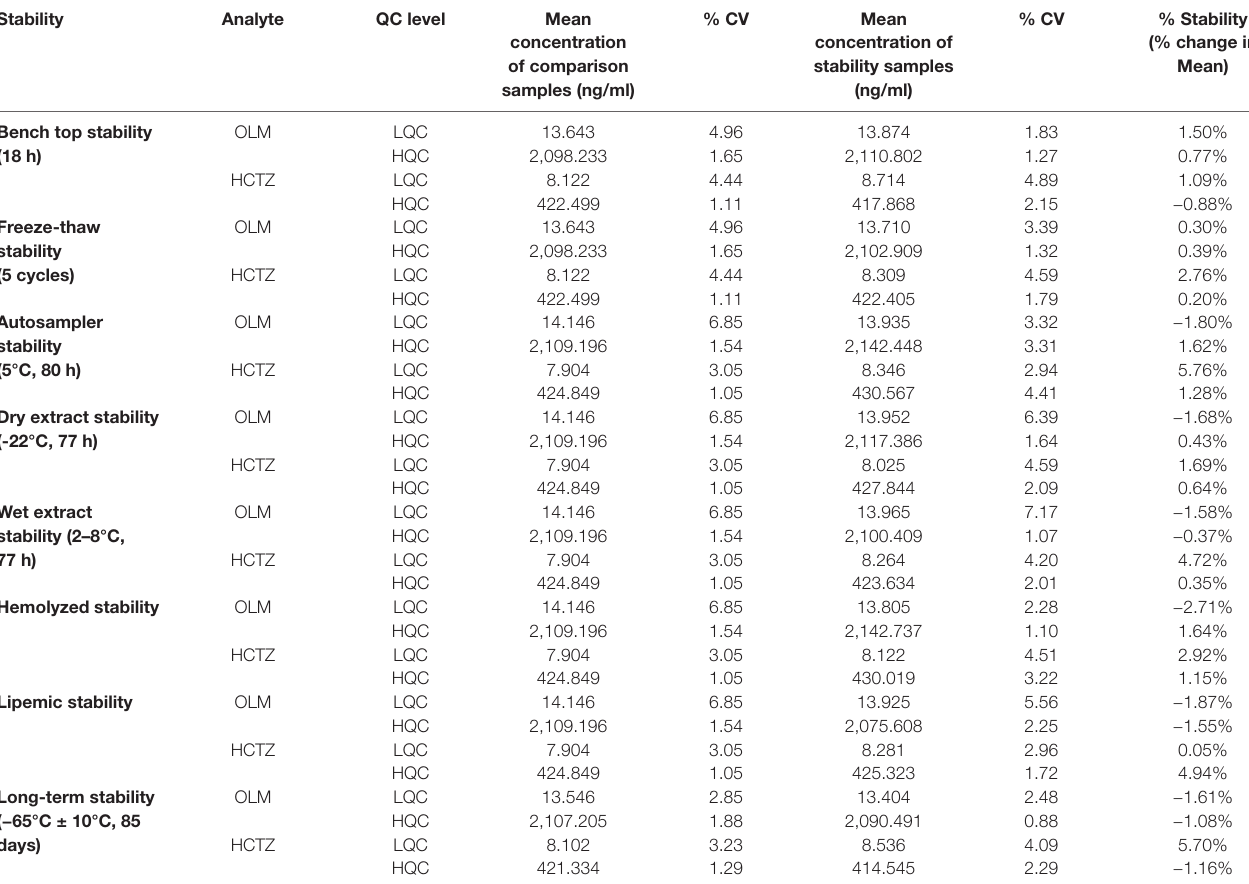
TABLE 5 | Stability results of OLM and HCTZ ( n = 6).